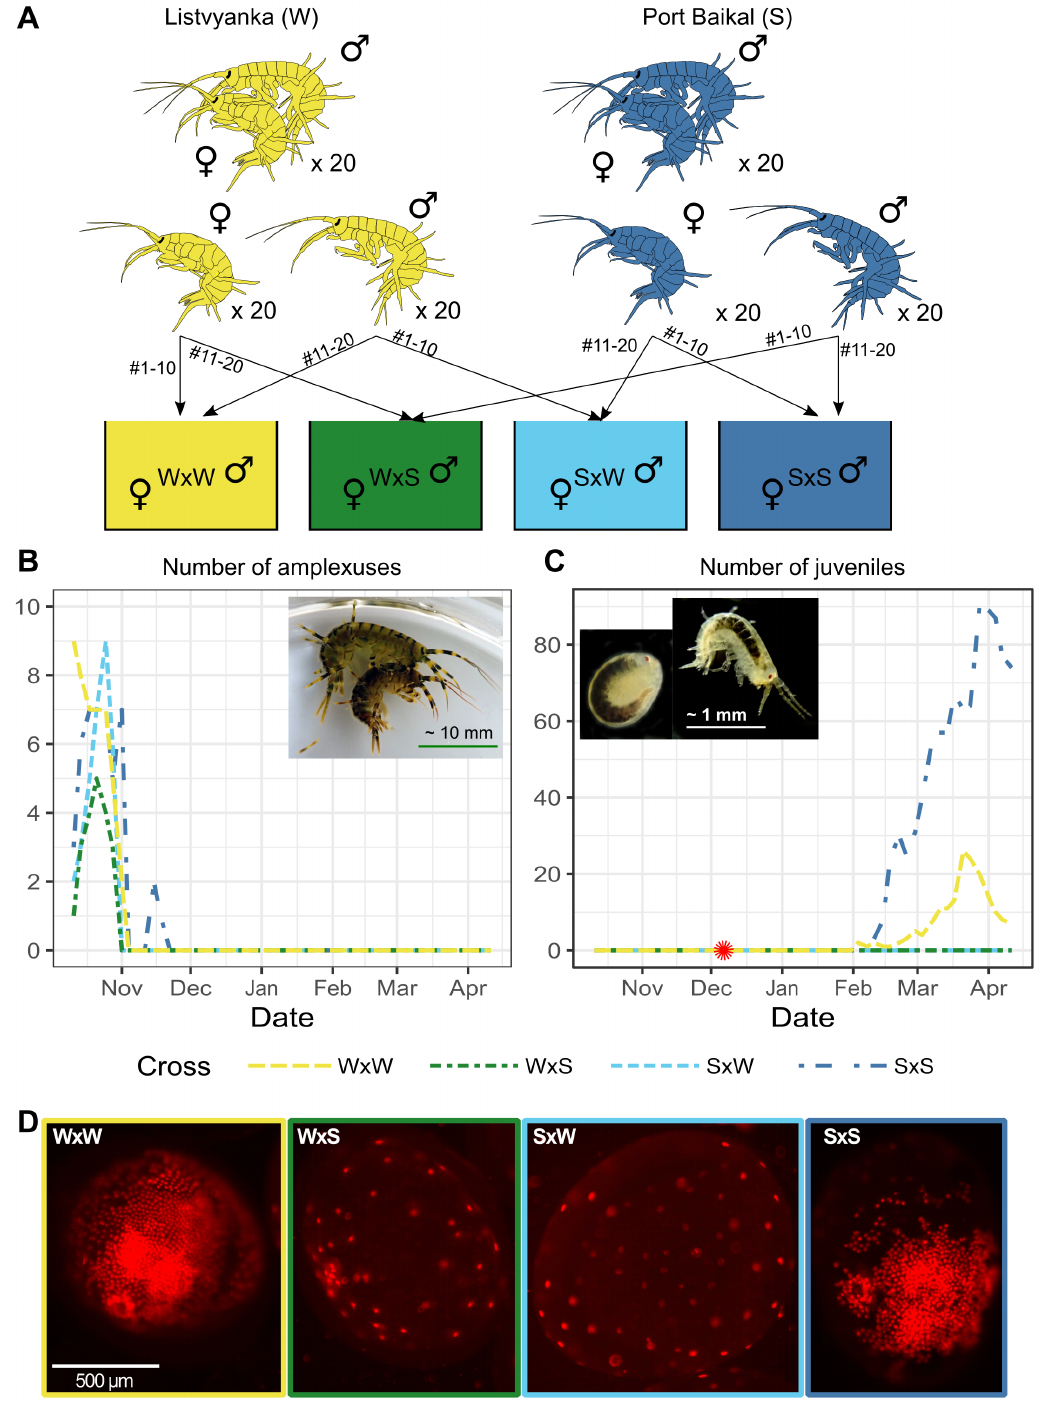
Figure 3. Experimental crossing. ( A ) The overview of the experimental design and designation of crosses; ( B ) the dynamics of amplexus formation. Inset: a typical amplexus; ( C ) the dynamics of juvenile hatching. Inset: an egg close to hatching and a newly hatched animal. The asterisk symbol marks the time point of embryo sampling. Please refer to Table S3 for raw counts; ( D ) a representative embryo from each cross, stained with a nucleic acid staining agent propidium iodide (PI) to visualize cell nuclei. For more photographs, see Figure